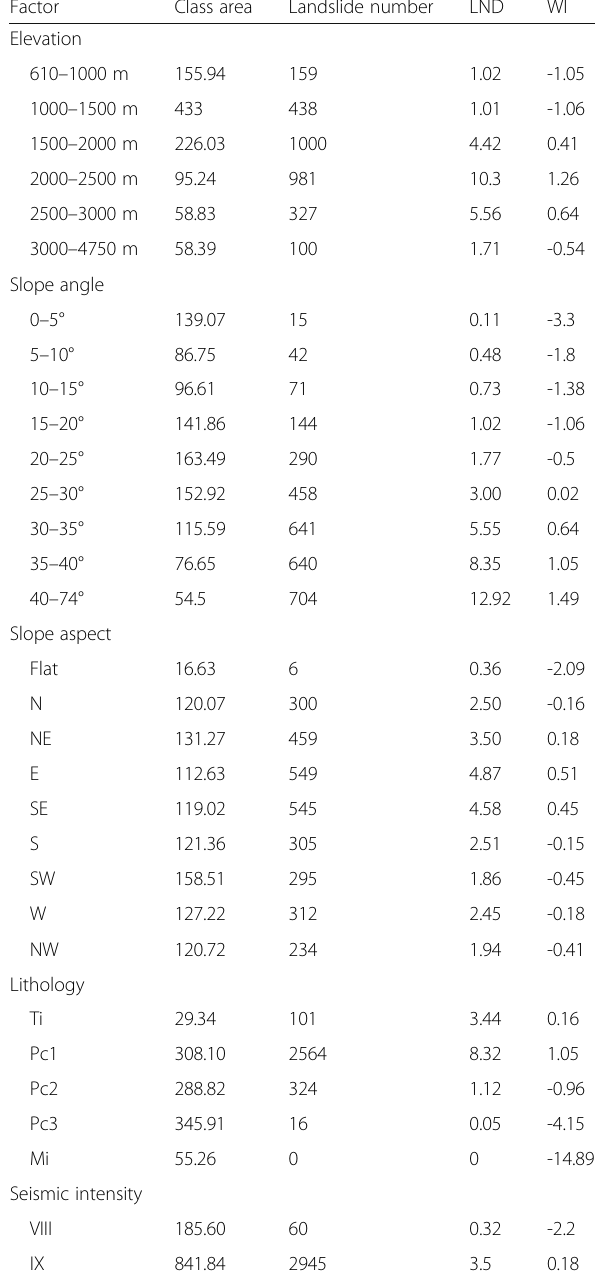
Table 3 Weight index values of various classes of